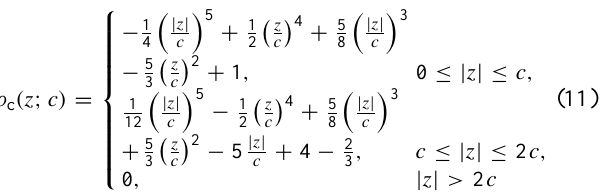
Fig. 1. The horizontal correlation functions: Power Law (red), Gaussian (blue), the Compact 5th-order piecewise rational function (green) and the windowed power law (yellow); the length scale L = 500 km.